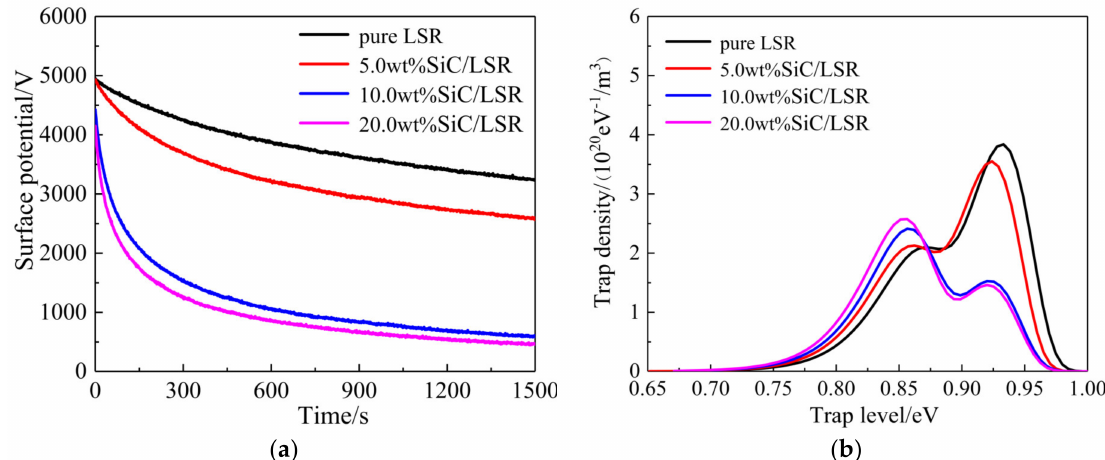
Figure 8. ( a ) Isothermal surface potential decay (ISPD) curves; and ( b ) trap level distributions of SiC/LSR